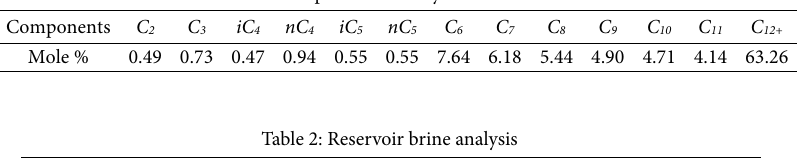
Fig. 2: SEM analysis of the Titanium oxide Fig. 2. SEM analysis of the Titanium oxide nanoparticles